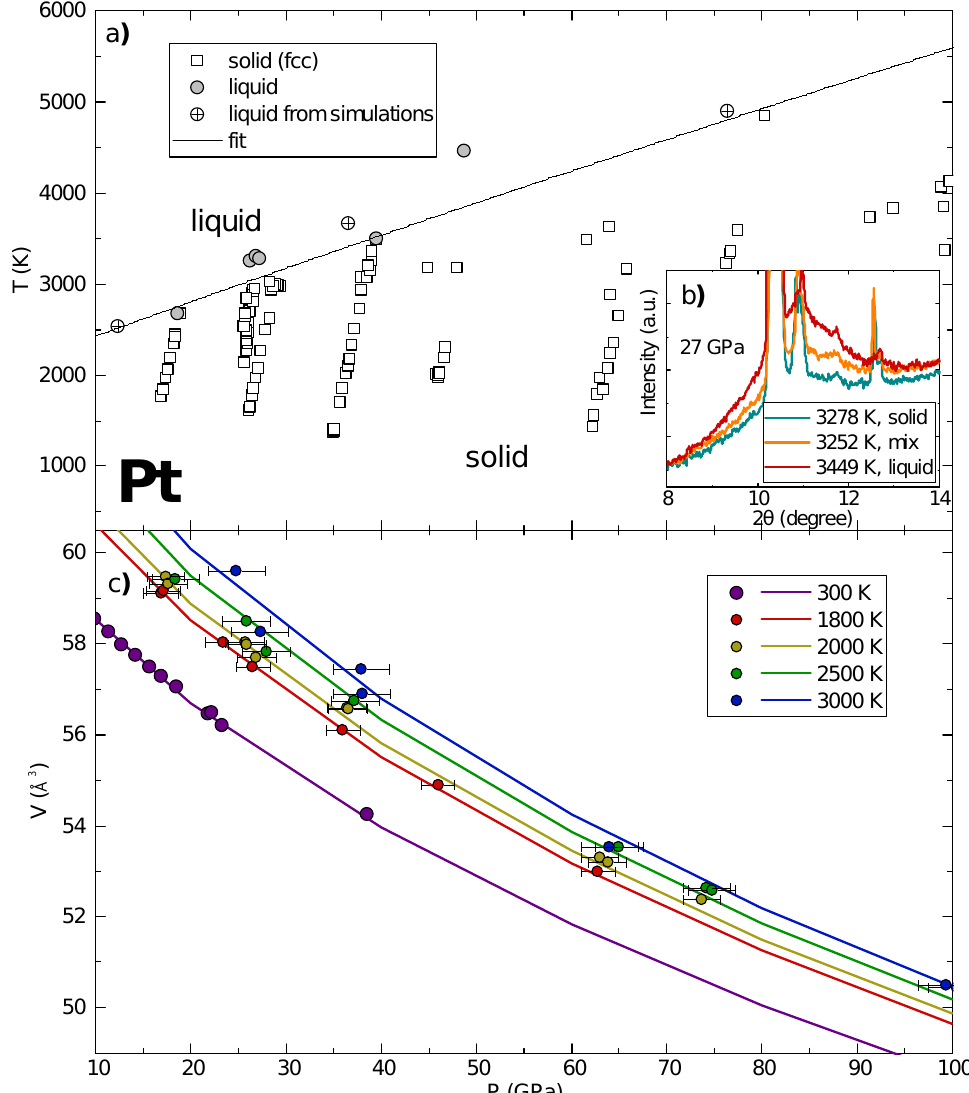
Figure 8. Example results of a study on Pt performed using LH-DAC combined with XRD [81]. ( a ) High P -high T phase diagram of Pt. ( b ) Example of a solid/liquid transition (characterized by the appearance of a diffuse signal in the diffraction pattern) observed in Pt at around 3300 K and 27 GPa. ( c ) Thermal equation of state of Pt determined along four